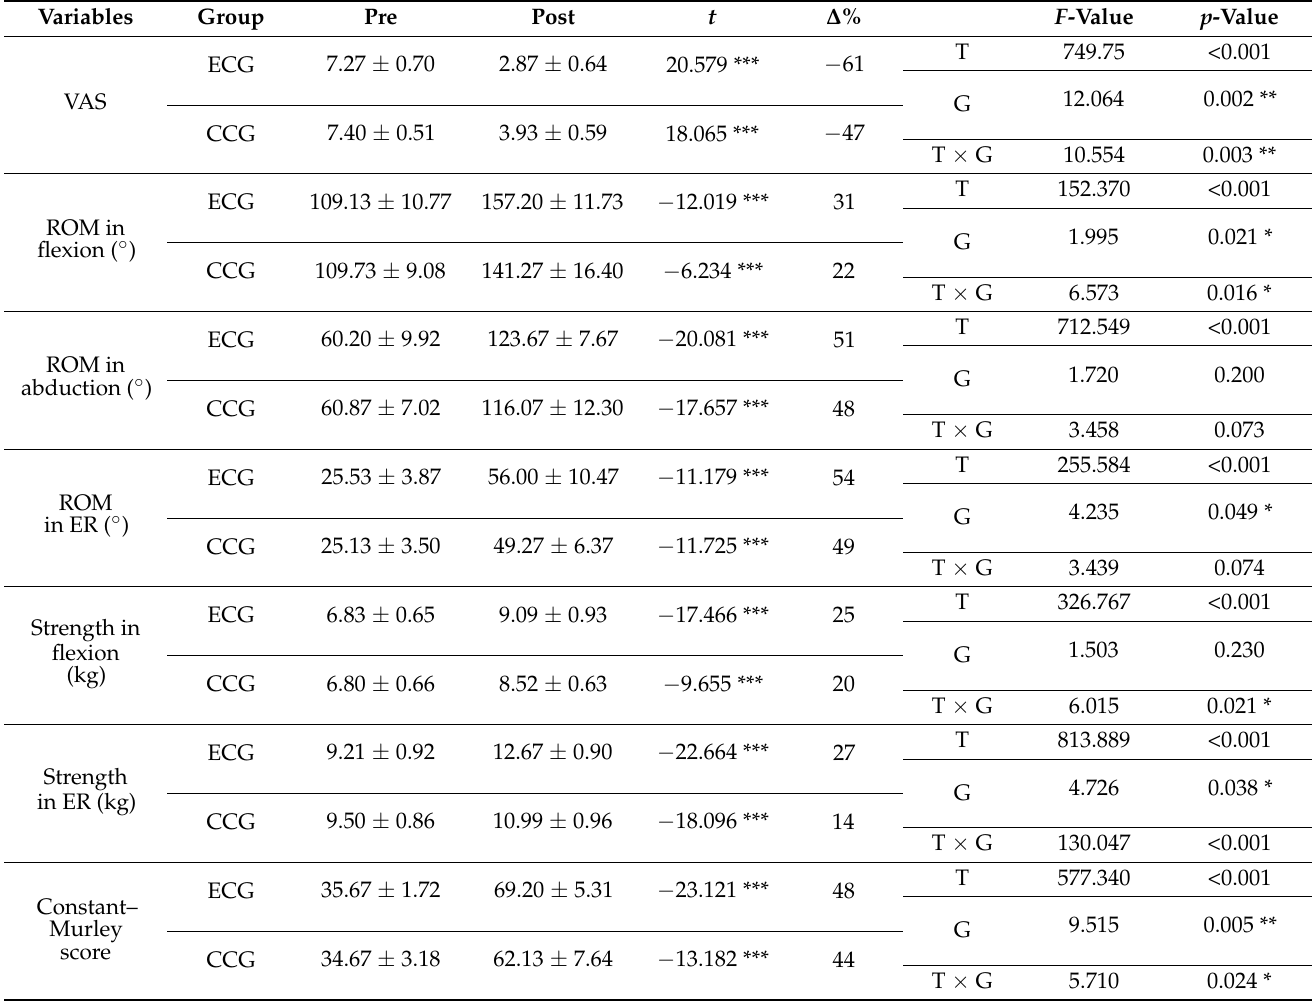
Table 3. Clinical outcomes after an exercise intervention between the